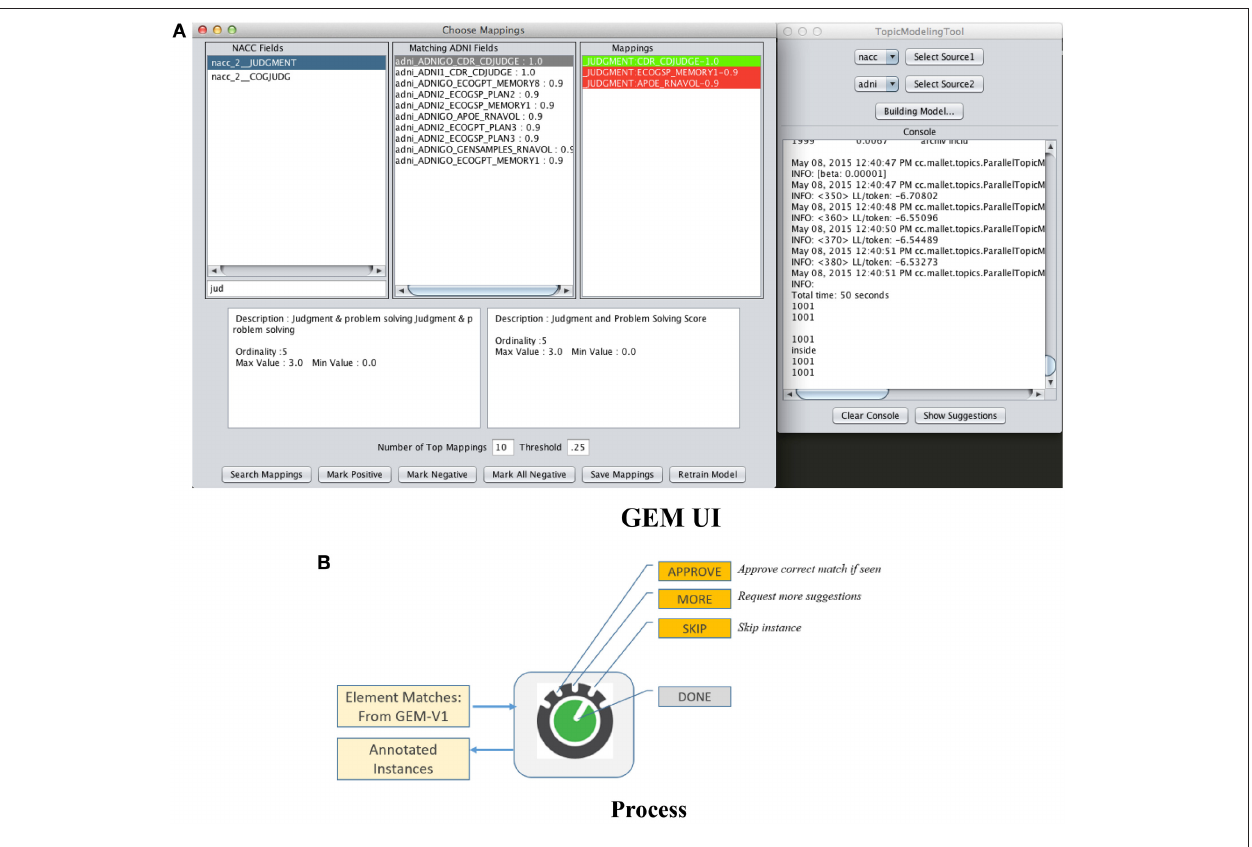
FIGURE 5 | GEM data mapping and active learning interface. (A) GEM UI, (B)